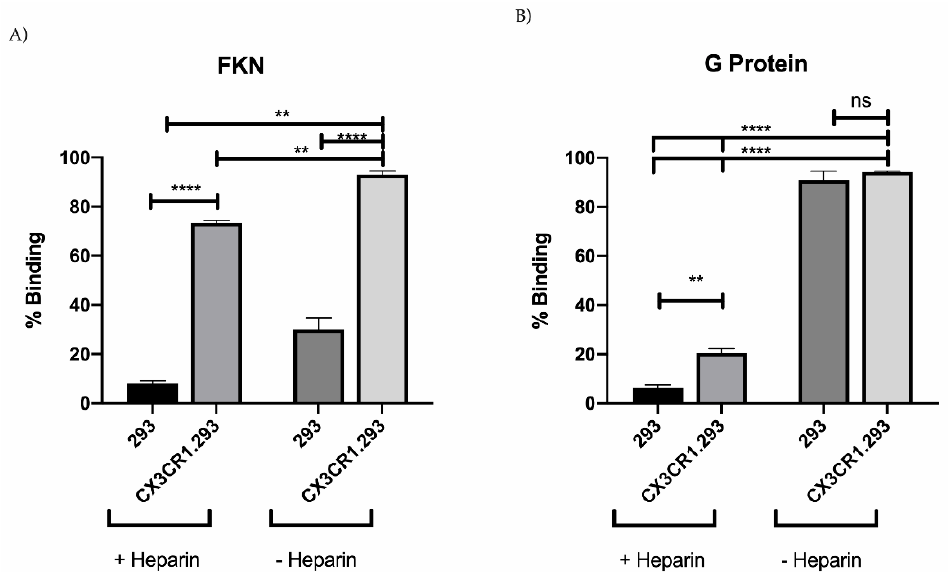
Figure 6. FKN and G protein CX3C binding to CX3CR1 in the presence or absence of heparin. 20 nM FKN (CX3CL1) ( A ) or 500 nM G protein ( B ) was pre-incubated with or without 5 µ g/mL heparin to block non-specific binding. FKN binding was observed using Streptavidin-PE. RSV G protein was observed using anti-G protein mAb (clone 130-5F) followed by secondary anti-mouse conjugated to AlexaFluor-488. 20,000 events were collected. Bars represent the mean of three independent experiments + SEM analyzed by one-way ANOVA where ** p < 0.01, **** p < 0.0001, ns (no significance). To determine if anti-RSV Abs could block CX3C-CX3CR1 interaction, IgG was purified from pooled immunogen vaccinated sera, quantified, and equal concentrations of IgG were used throughout the study. Then, 500 ng of purified IgG was incubated with either 20 nM FKN or 500 nM RSV G protein in the presence of 5 µ g/mL heparin. The concen- tration chosen was determined from a gradient of FKN or G protein concentrations that were evaluated for CX3CR1.293 cell binding, which was consistent with related binding studies [49]. Binding of FKN or RSV G protein CX3C binding to CX3CR1 was determined by flow cytometery [47]. No measureable IgG tested inhibited FKN binding to